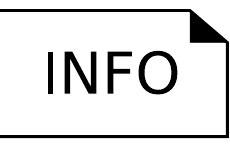
Figure 2.39: The Entity Relationship glyph for annotation .